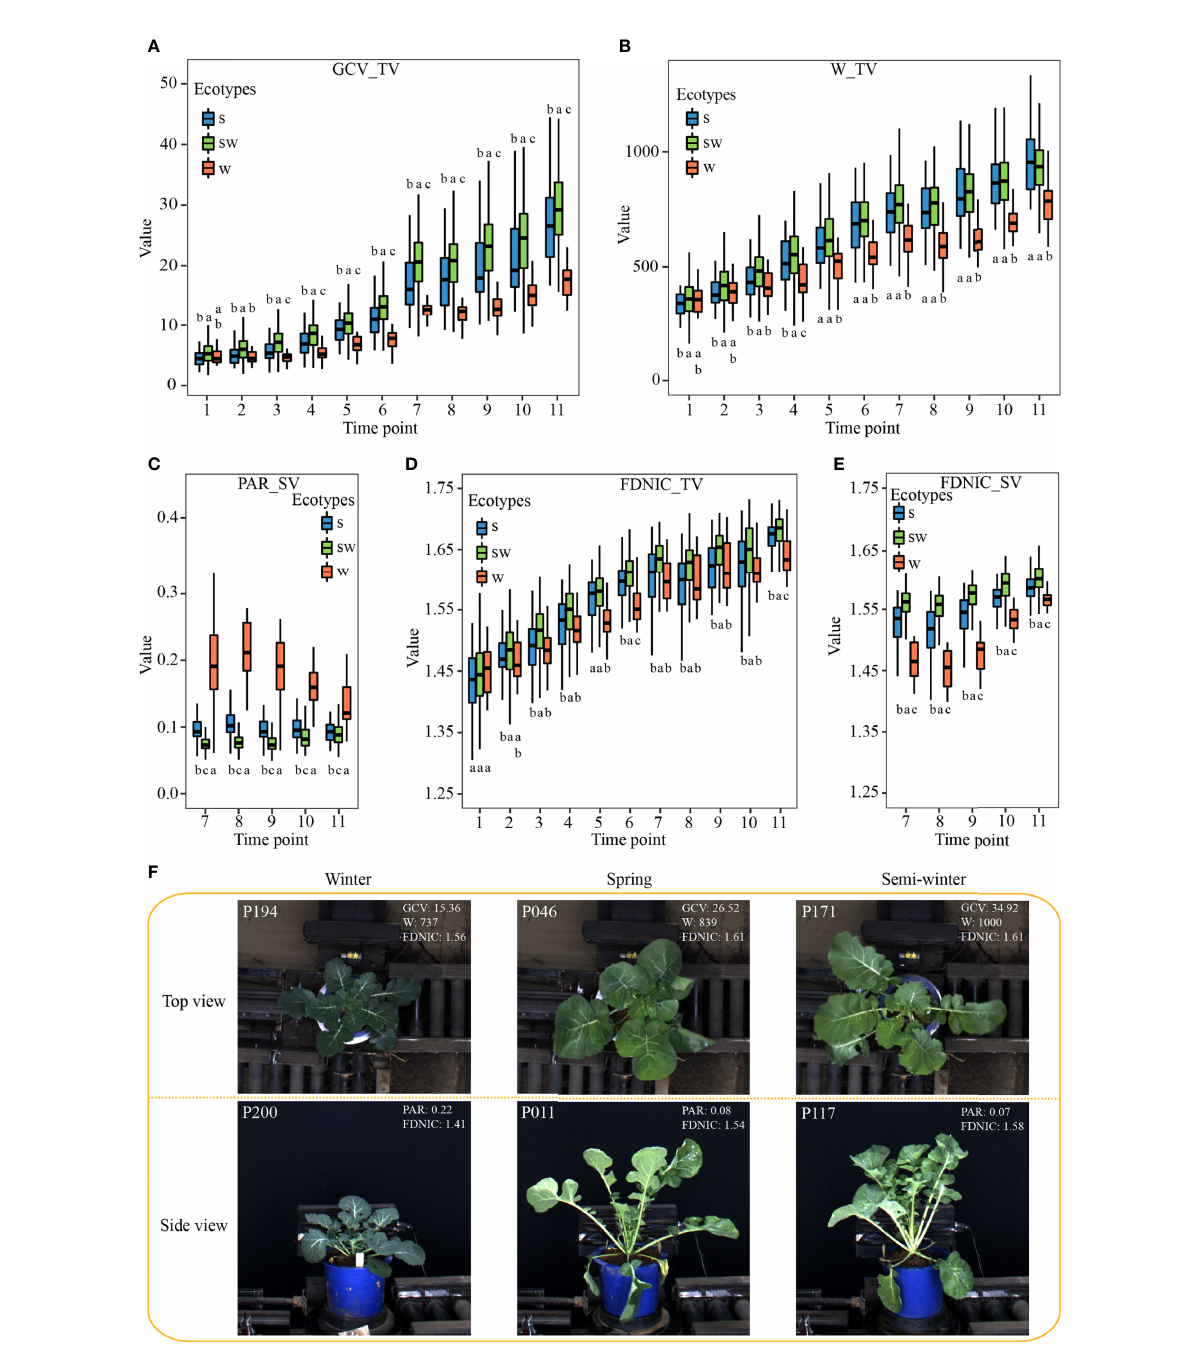
FIGURE 3 Characteristics of the subset of i-traits contributing to ecotype divergence among the three ecotypes. (A – E) The box plots of GCV_TV (A) , W_TV (B) , PAR_SV (C) , FDNIC_TV (D) , and FDNIC_SV (E) from T1 to T11 among the three rapeseed ecotypes. Differences between the ecotypes were analysed by Wilcoxon rank-sum test and different letters represent signi fi cant difference (P < 0.05). (F) : Plant morphology of the three rapeseed ecotypes from T7 in top view and side view. The top-left numbers indicated the No. of displayed